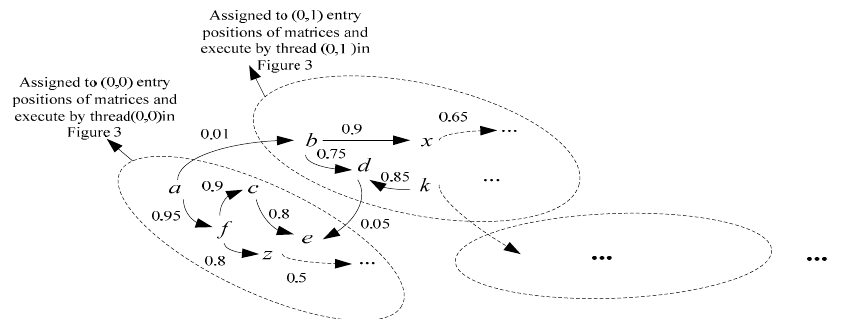
Figure 5. The proposed object-weighted network and classification. Objects that have higher communication rates are organized within the same groups (dashed ellipses). The number of objects per group should satisfy Equation (3) and objects are assigned to the same entry positions within the matrices, enabling execution by the same thread.